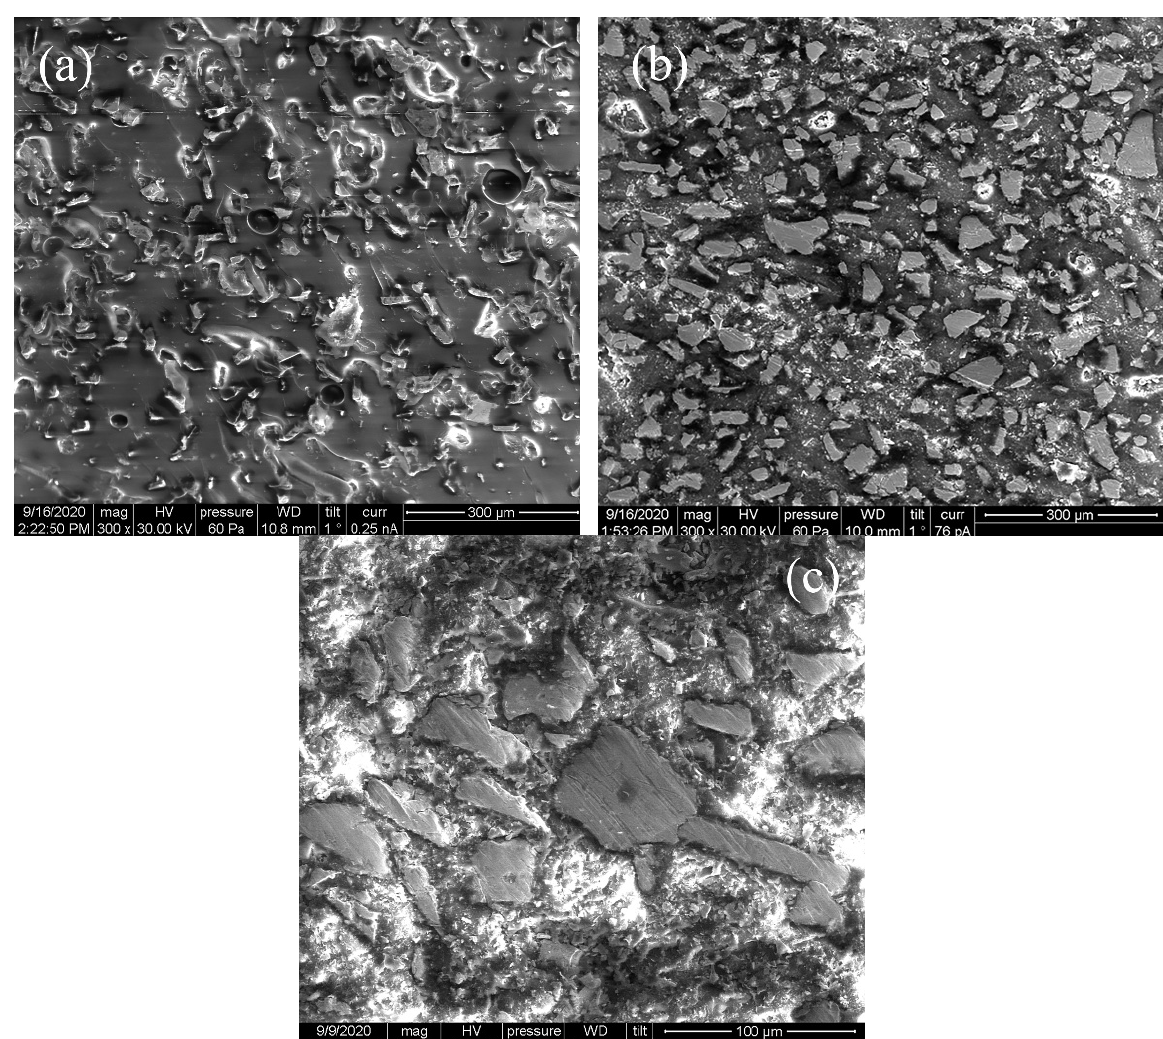
Figure 2. The structure of the composite medium with 15% flakes: chip ( a ); its top surface ( b ); the structure of the composite medium with 30% flakes obtained from its top surface ( c ).